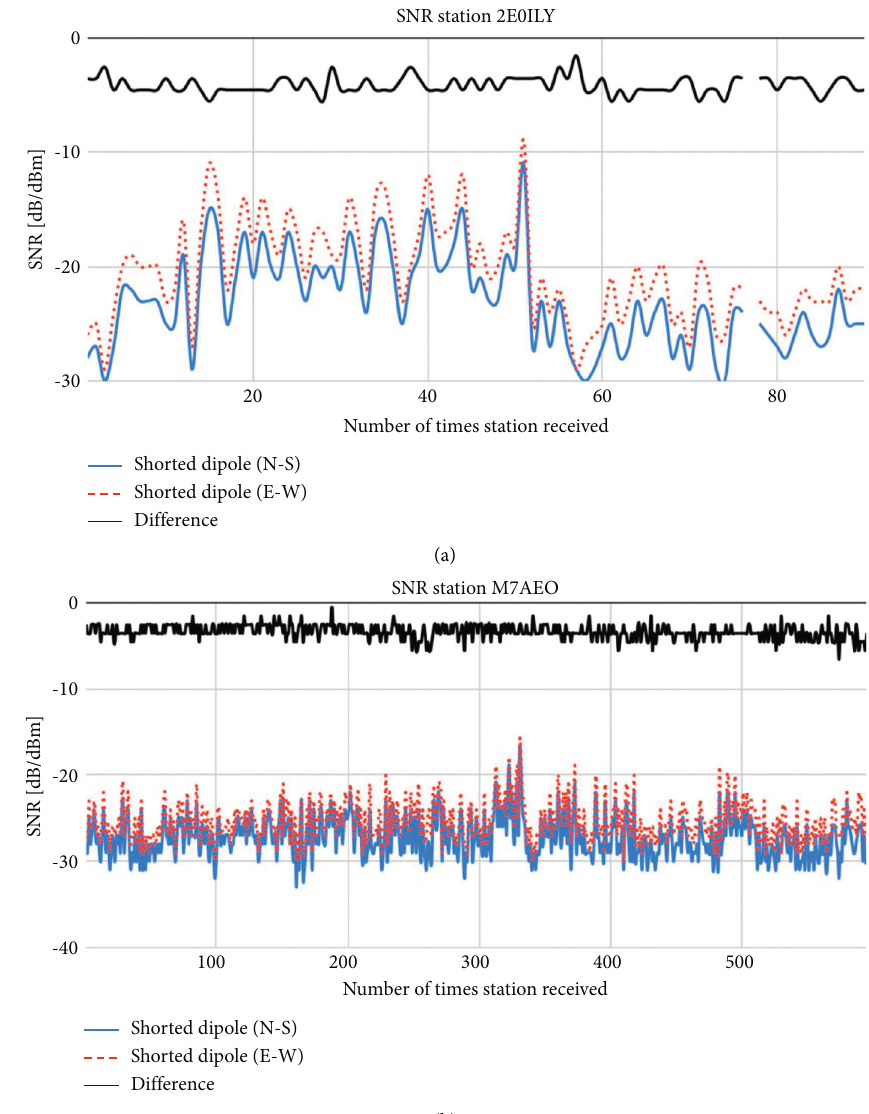
Figure 9: The SNR values of both adapted shorted dipoles for reception of the 2E0ILY and M7AEO stations (a and b). In each figure, the solid blue line represents the first adapted shorted dipole positioned in the north-south direction, and the dotted red line the second adapted shorted dipole positioned in the east-west direction. The difference between both SNR values is shown at the top of both charts as a solid black line. (a) Received SNR values for both antennas of station 2E0ILY. (b) Received SNR values for both antennas of station Table 1: Summary of the SNR differences obtained during the comparisons between antennas carried out during this study. Two identical adapted shorted dipoles Station Antennas not shifted (dB) Antennas shifted by 90 ° (dB) Antennas shifted by 90 ° (dB) M7AEO − 4 to +2 +1 to +6 − 5 to − 2 2E0ILY − 5 to +2 − 3 to +5 − 5 to − 2 Average SNR difference (when shifted by 90 ° ) 3 3 (dB)